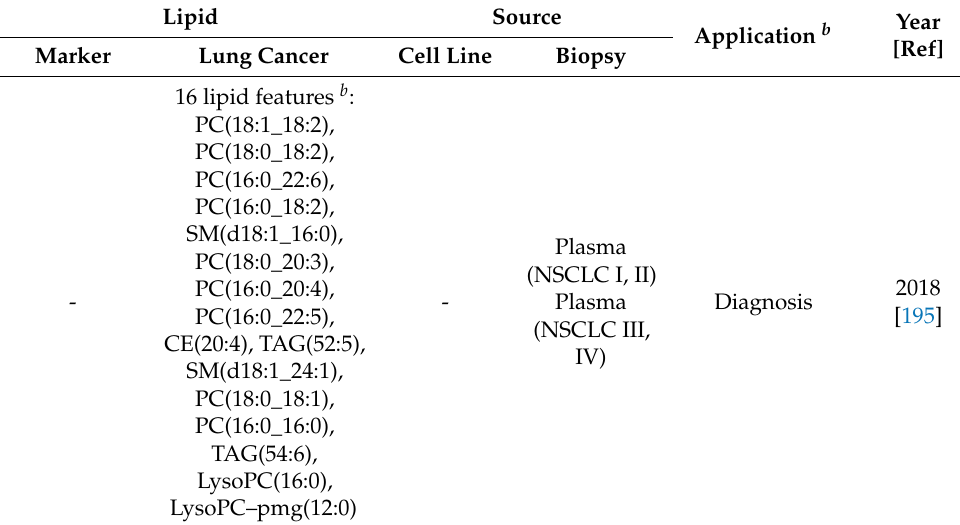
Table 3. Lipid composition and application of lung cancer exosomes. Lipid Source